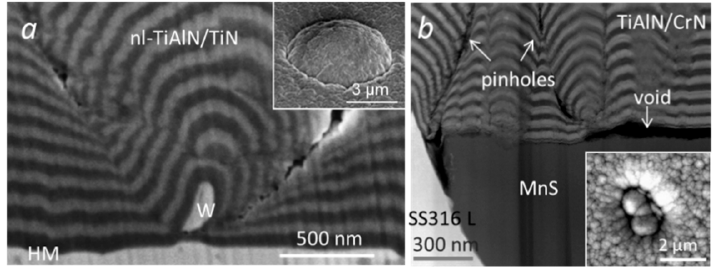
Figure 24. The seed particle in the nodular defect ( a ) or pinholes ( b ) can be clearly identified from the shape of layer contours in sputter-deposited nl-TiAlN/CrN hard coatings.